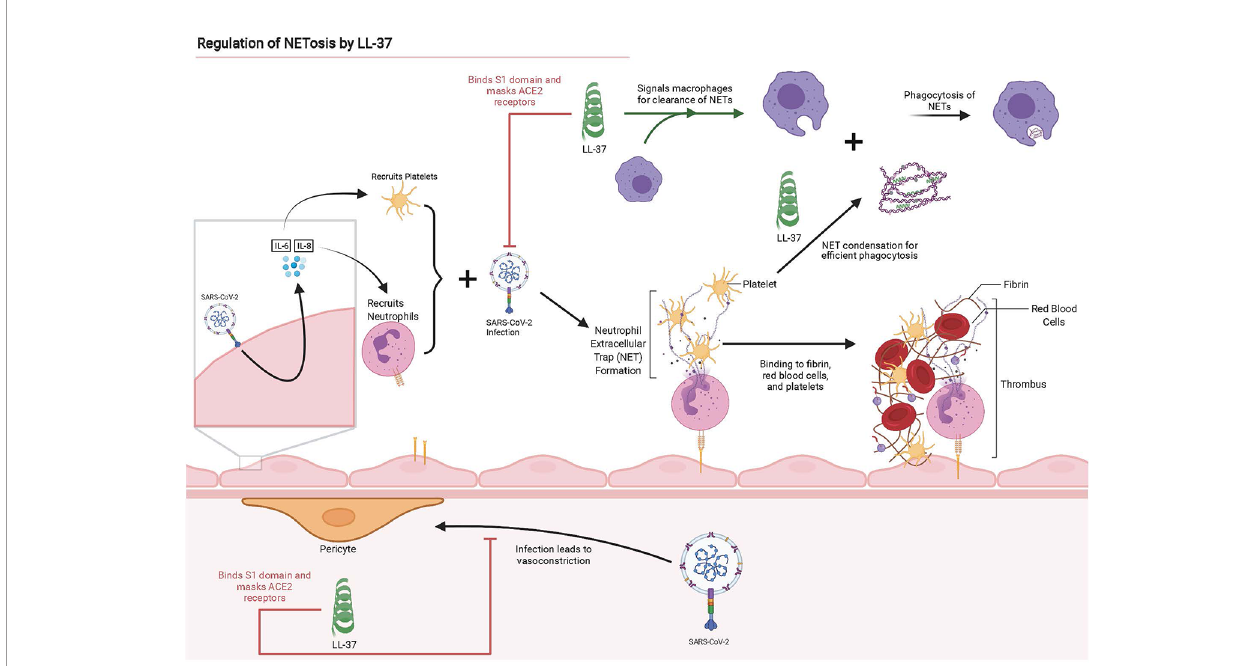
FIGURE 2 | Graphical summary of interactions between SARS-CoV-2 and lung epithelium, instigating NET production and the disruption or antagonistic behavior of LL-37 for these interactions. Adapted from “ The Propagation of Immunothrombosis by Leukocytes and Platelets ” , by BioRender.com (2021). Retrieved from https://